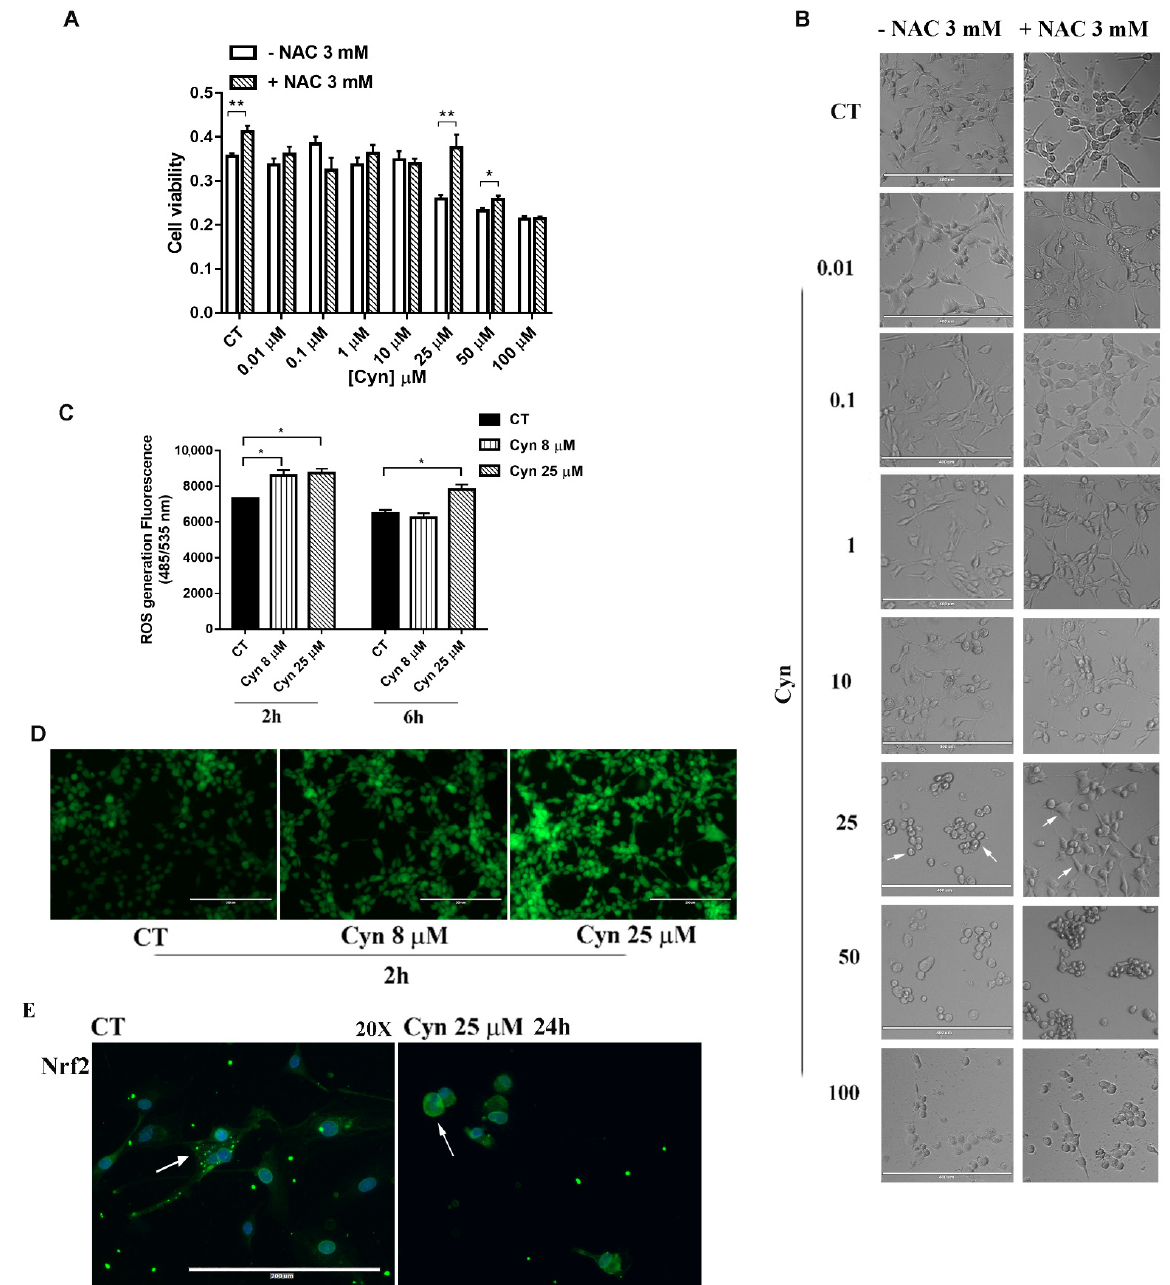
Figure 2. Cyn-induced oxidative stress in human glioblastoma U-87 MG cells. ( A ) Pretreatment of U-87 MG cells with NAC 3 mM for 4 h, followed by incubation for 24 h with Cyn 0.01, 0.1, 1, 10, 25, 50 and 100 µM. DMSO 0.1% was used as the vehicle control. ( B ) Preincubation with NAC 3 mM for 4 h preserved U-87 MG from Cyn-induced morphological change, since the cells maintained their protrusions rather than appeared round-shaped (white arrows). ( C ) Quantitative analysis of ROS generation in U-87 MG cells under 2 and 6 h of treatment with Cyn 8 and 25 µM. DMSO 0.1% was used as the vehicle control. ( D ) Qualitative analysis of ROS production after 2 h of exposure to Cyn 8 and 25 µM. ( E ) Immunofluorescence staining of NRF2 in U-87 MG treated for 24 h with Cyn 25 µM, which showed a nuclear localization with respect to the control cells treated with 0.1% DMSO (white arrows). Magnification 20 × . Data were analyzed by a Student’s t -test, p -value < 0.05. According to GraphPad Prism 7 software, * p -values from 0.01 to 0.05 (significant) and ** p -values from 0.001 to 0.01 (very